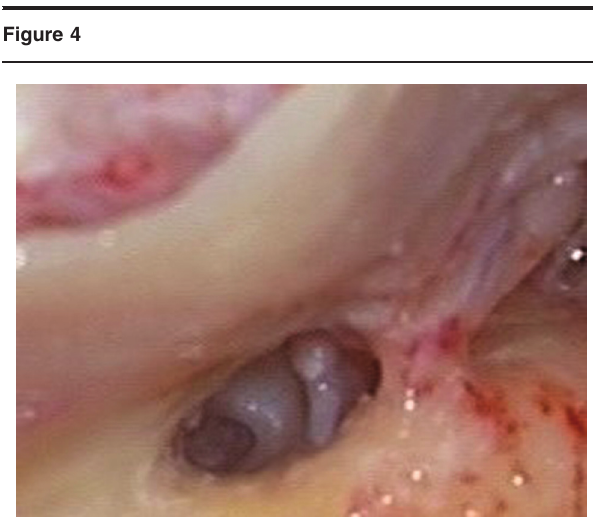
RWM partially visible. RWM, round window membrane.